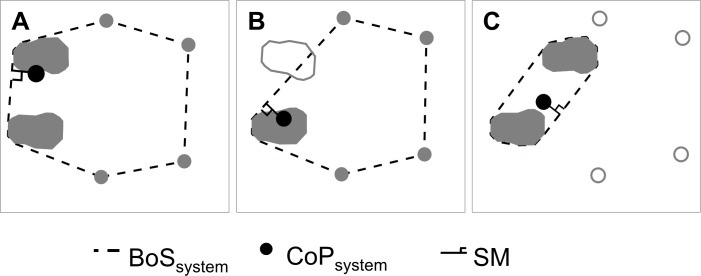
Examples of combined centre of pressure, combined base of support and system Stability Margin.Examples of combined centre of pressure, combined base of support and system Stability Margin for 3 cases: A) all 6 feet on the ground; B) 4 rollator feet on the ground and user in single support on their right foot; C) user in double support and rollator fully airborne (e.g. being lifted up a step). Grey foot prints indicate feet that are grounded; white foot prints indicate feet that are airborne.